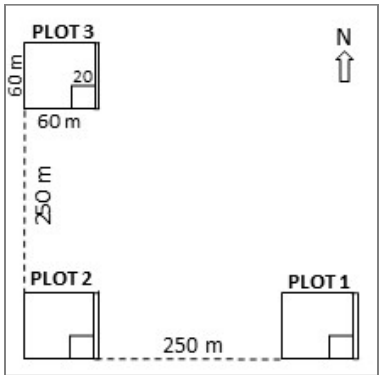
Figure 2. Cluster design. Shrubs were inventoried in the subplot in the southeast corner of each plot, and animal excrement was collected from the transect at the eastern